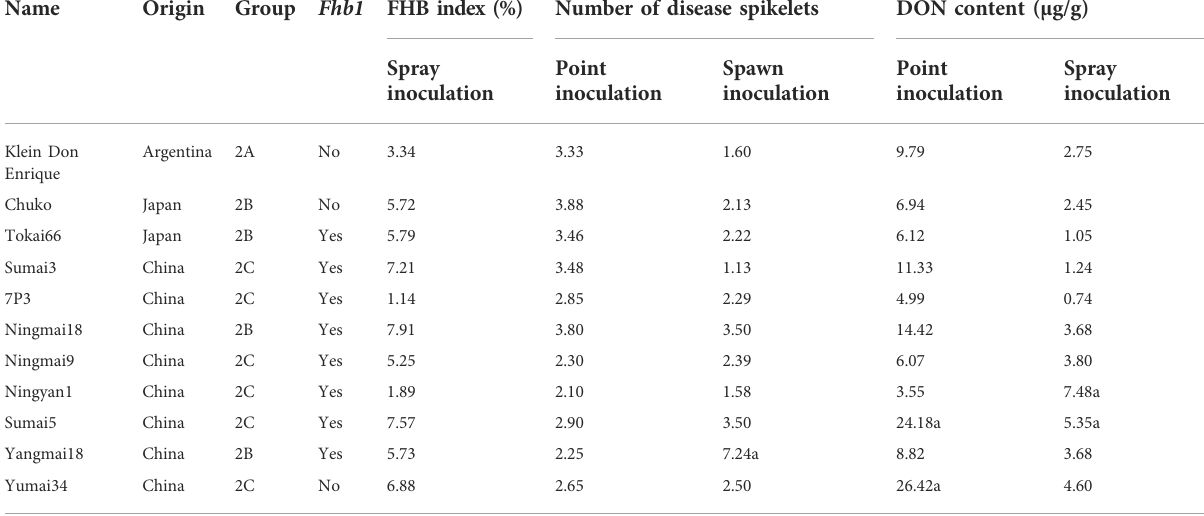
TABLE 2 Top performers in FHB and DON traits across